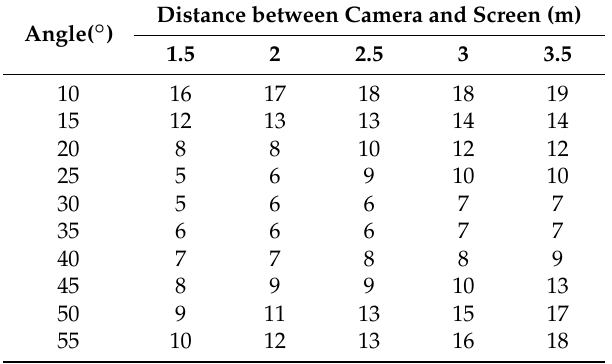
Table 3. Position errors according to distance and angle between camera and